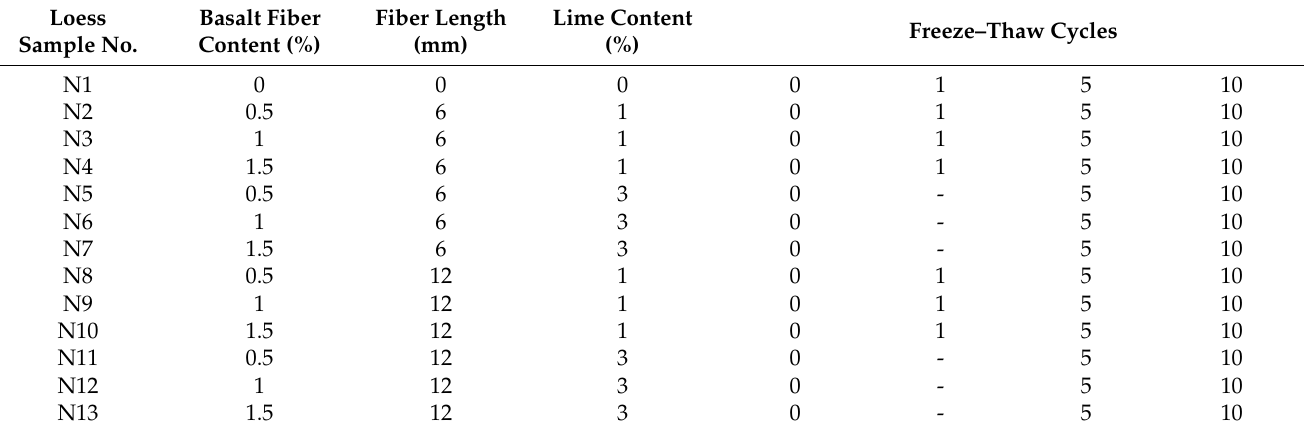
Table 4. Test scheme.